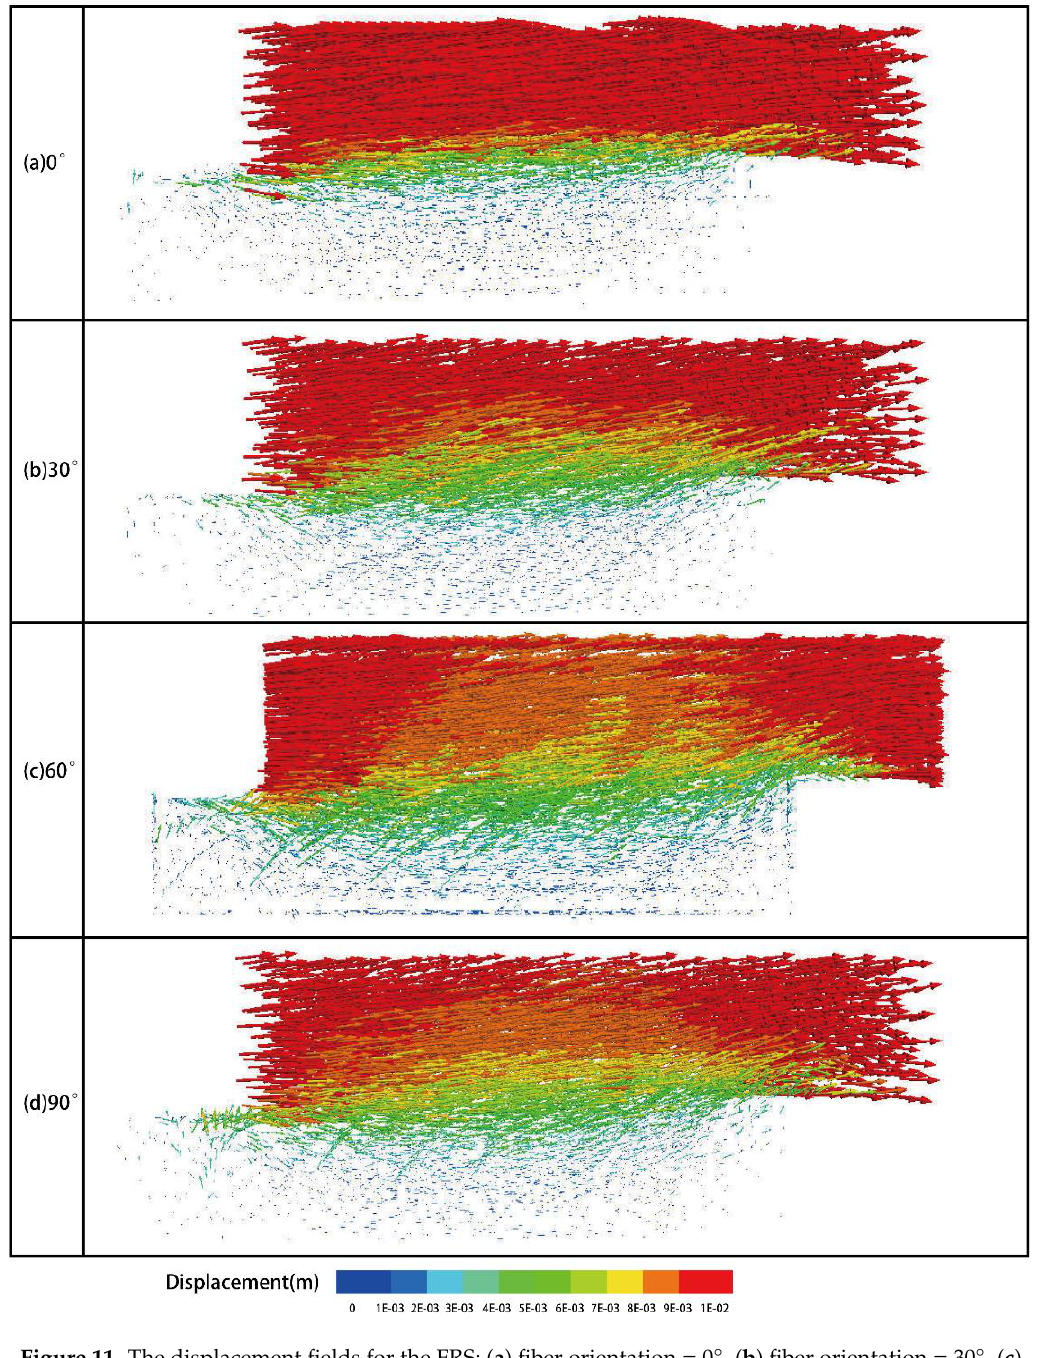
Figure 11. The displacement fields for the FRS: ( a ) fiber orientation = 0 ◦ , ( b ) fiber orientation = 30 ◦ , ( c ) fiber orientation = 60 ◦ , and ( d ) fiber orientation = 90 ◦.